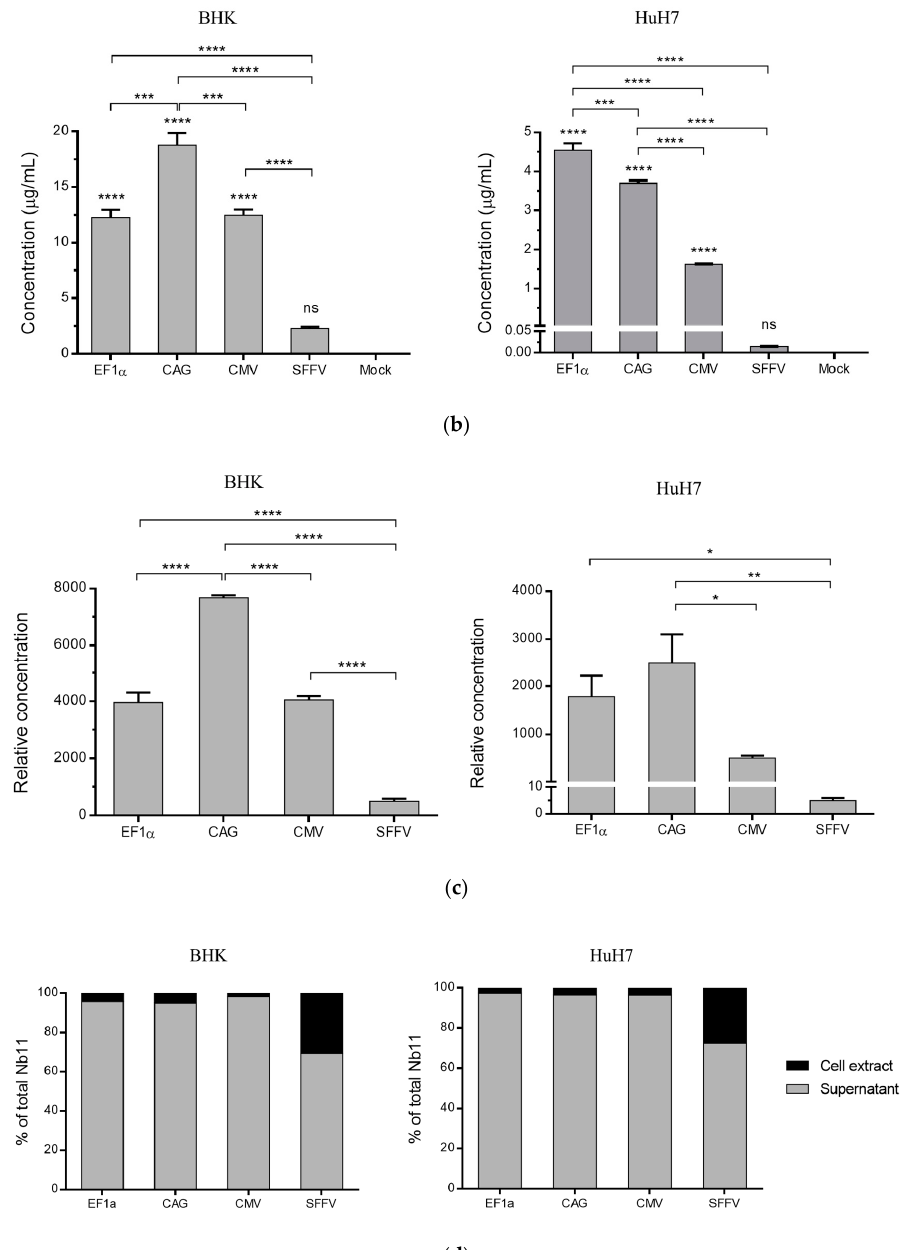
Figure 4. Quantification of Nb11 expressed from BHK and HuH-7 eukaryotic cell lines. Cells were transfected with 2 µg/well of adeno-associated virus (AAV) plasmids coding for Nb11 under the indicated promoters, and 48 h later supernatants and cell extracts were collected for analysis. ( a ) Schematic representation of AAV vectors coding for Nb11 under the control of four different promoters. ( b ) Nb11 levels in supernatants of transfected BHK and HuH-7 cells, measured by a hPD-1 binding ELISA. Data represent the mean + SEM. ( c ) Relative levels of Nb11 in supernatants normalized with Nb11 DNA levels quantified from transfected cells, expressed as Nb11 concentration (ng/mL)/2 Δ Ct . ( d ) Analysis of the secretion of Nb11 in transfected BHK and HuH-7 cells. The percentage of secretion was calculated by quantifying the total amount of Nb11 present in supernatants and cell lysates and determining the percentage of Nb11 present in each type of sample. Asterisks above bars indicate comparison of each group with mock. Other comparisons are indicated by horizontal bars. * p < 0.05, ** p < 0.01, *** p < 0.001, **** p < 0.0001, ns: not significant. ITR: AAV inverted terminal repeats; EF1 α : human elongation factor 1 α promoter; CMV: human cytomegalovirus promoter; SFFV: Spleen focus-forming virus promoter; SP: signal peptide; HA: hemagglutinin tag; pA: synthetic polyadenylation